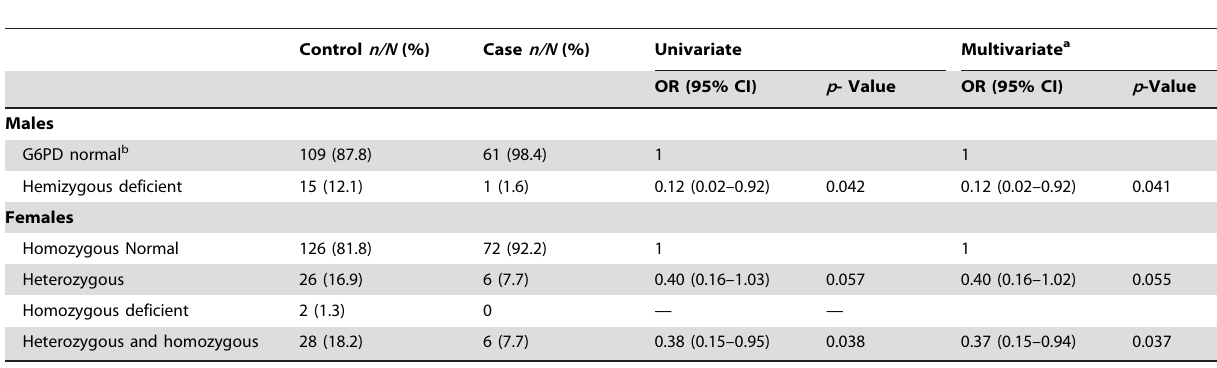
Table 5. Frequency of G6PD deficiency genotype between cases and